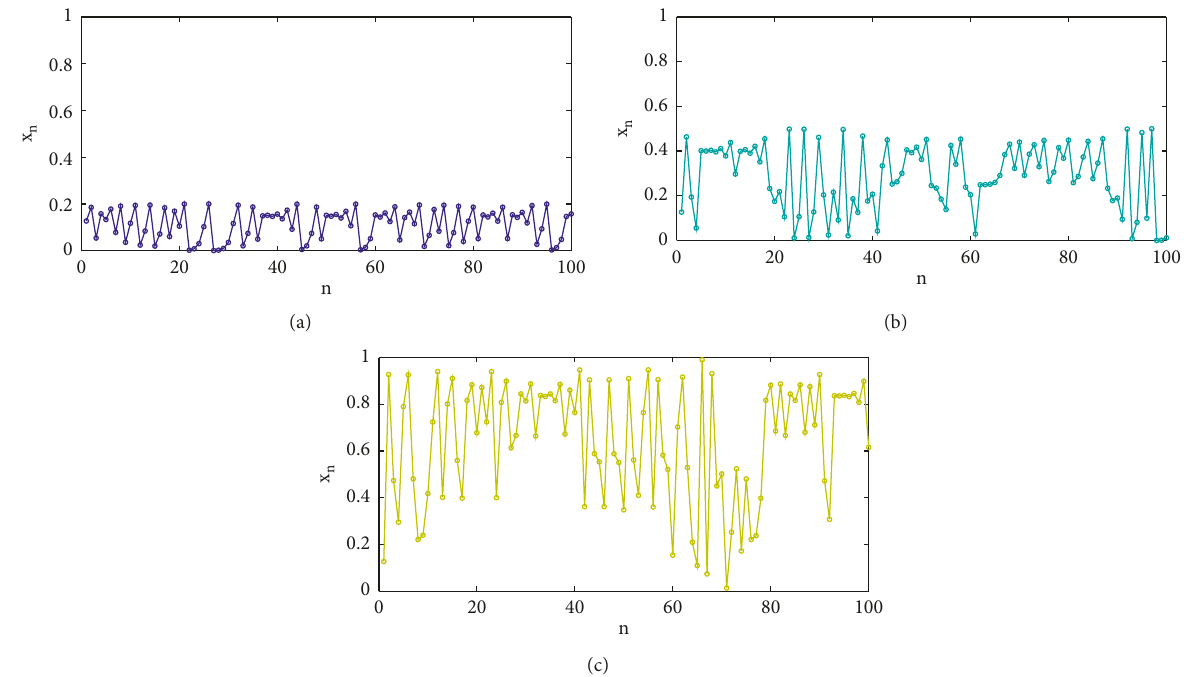
Figure 6: Time series obtained from trimodal map calculated with equation (36): (a) g